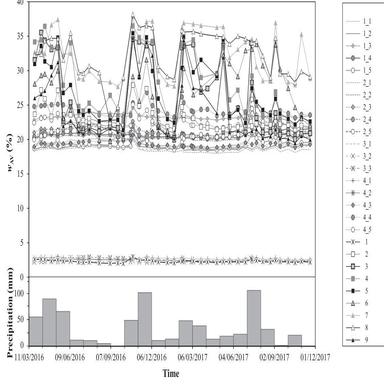
Correlation between measured water contents and monthly precipitation.